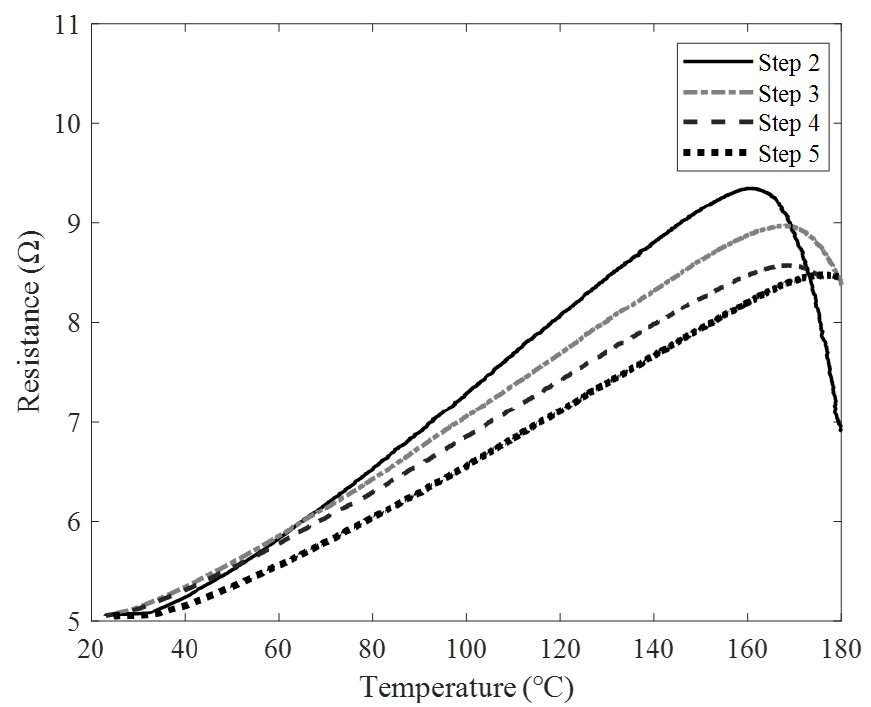
Figure 7. History of resistance change according to temperature change by steps. Table 1. Sensitivity and temperature measurement range according to the steps of the manufactured sensors.